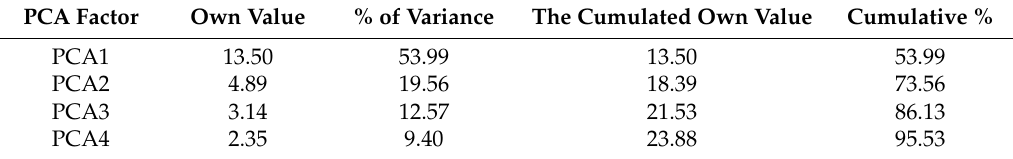
Table 8. Factor loadings of main four principal components for normalized varimax rotation.